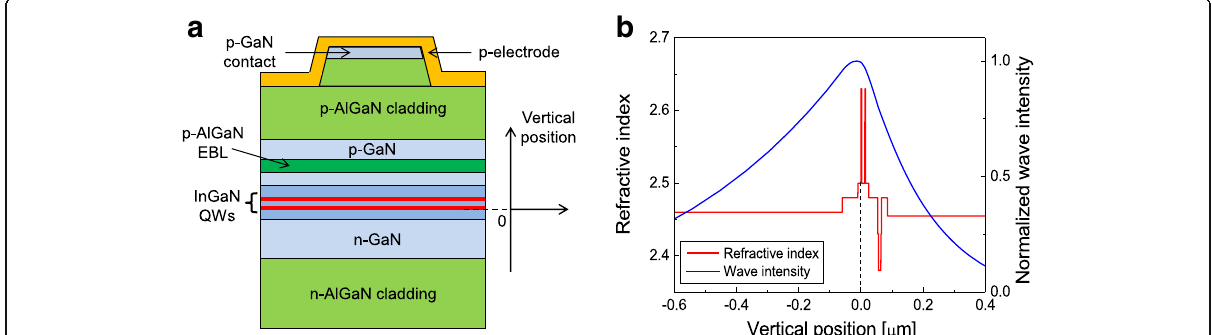
Fig. 1 a Schematic of the simulated LD structure. b Vertical profiles of the refractive index ( left vertical axis ) and the normalized wave intensity of the lasing mode ( right vertical axis ) of the simulated LD